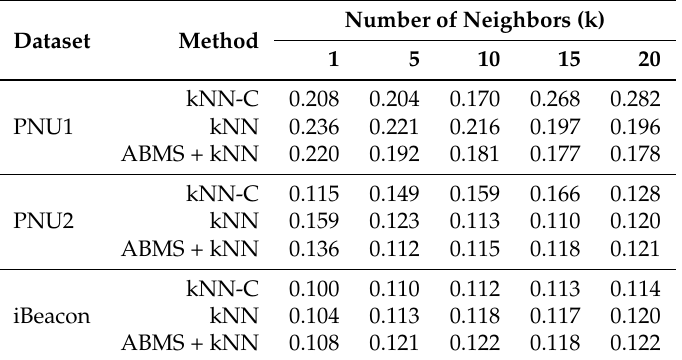
Table 5. Comparison of the performance of kNN methods based on Semantic Positioning Error Rate